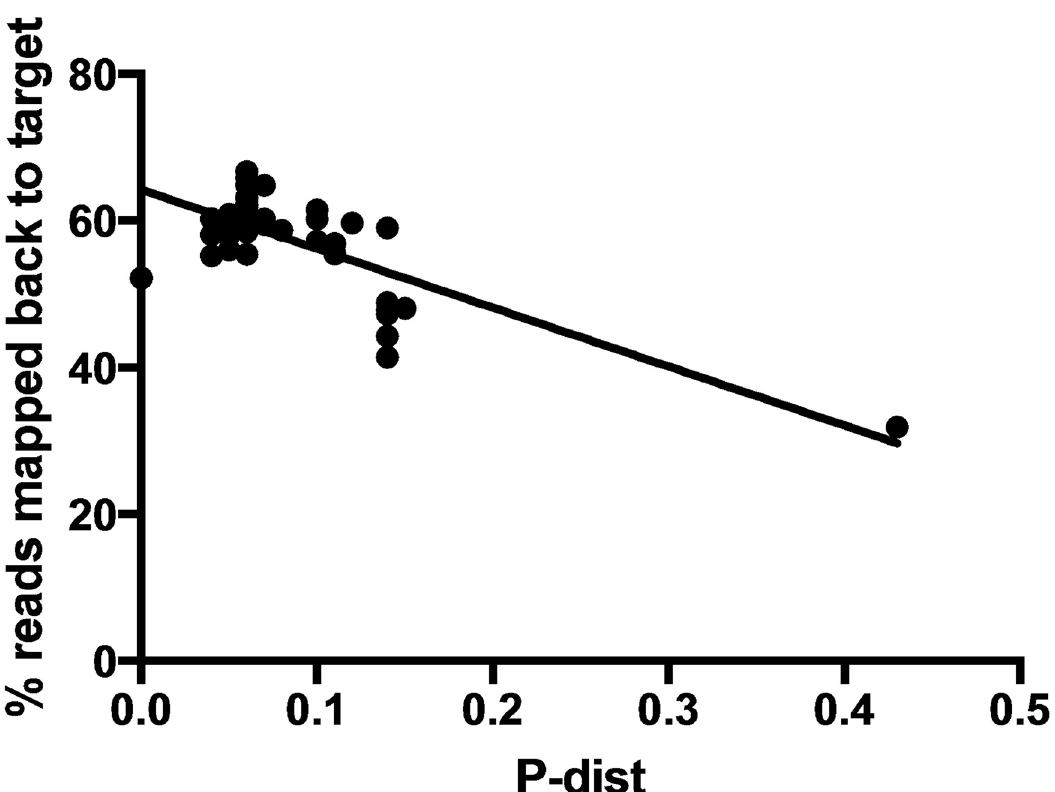
Fig 5. Linear regression of p-distance of each sample from Eucalyptus globulus subsp. pseudoglobulus versus percentage of reads mapped back to Eucalyptus grandis targets. The percentage of reads mapped and the p-distance is significantly negatively correlated ( R 2 = 0.36, P <